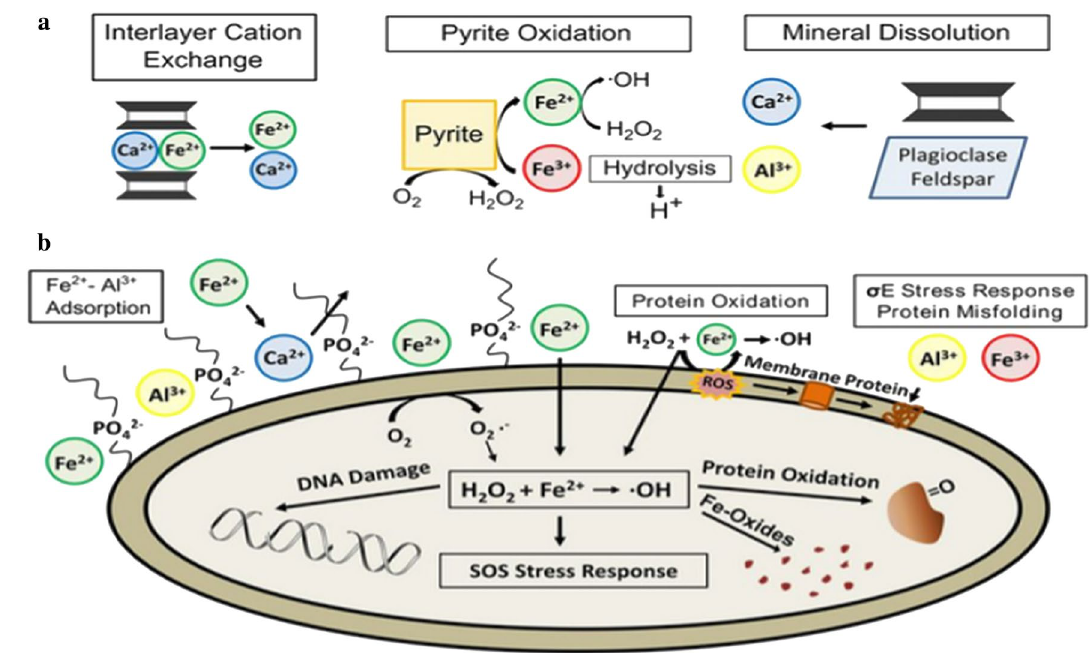
Fig. 19 The mechanism of antimicrobial activity of Oregon Blue clays